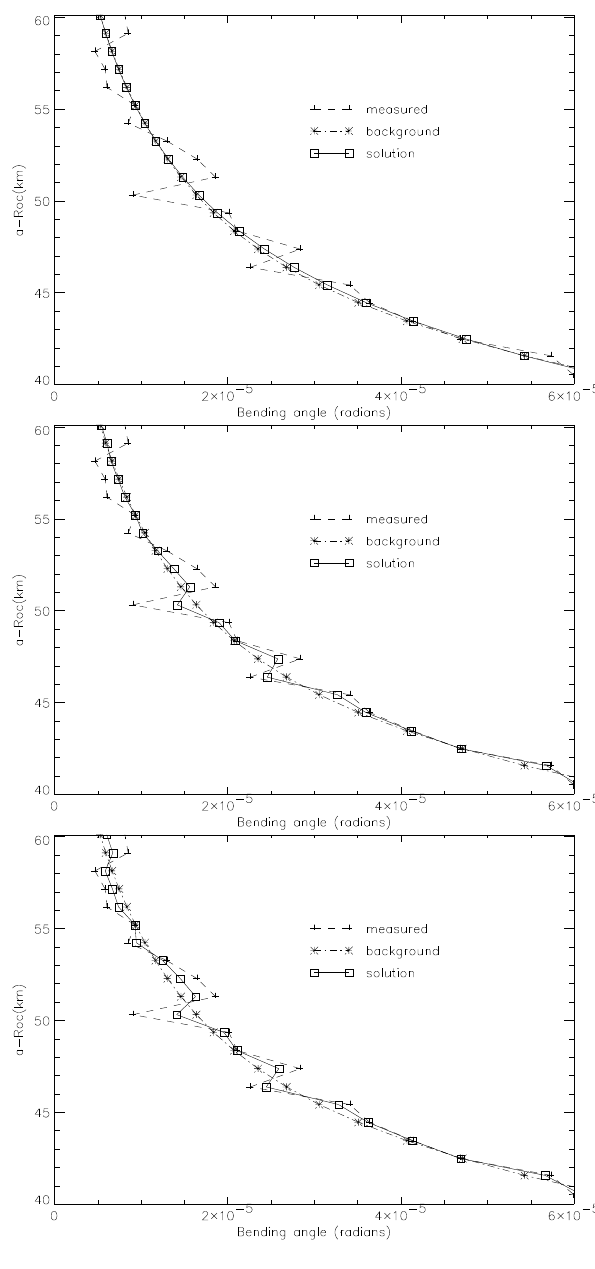
Fig. 1. Illustrating the smoothing of corrected bending angles for JPL profile ‘95-05-05-01:33met-gps25’ using (a) Eq. 6, (b) Eq. 8 and (c) Eq. 9. The vertical axis is ‘impact parameter minus radius of